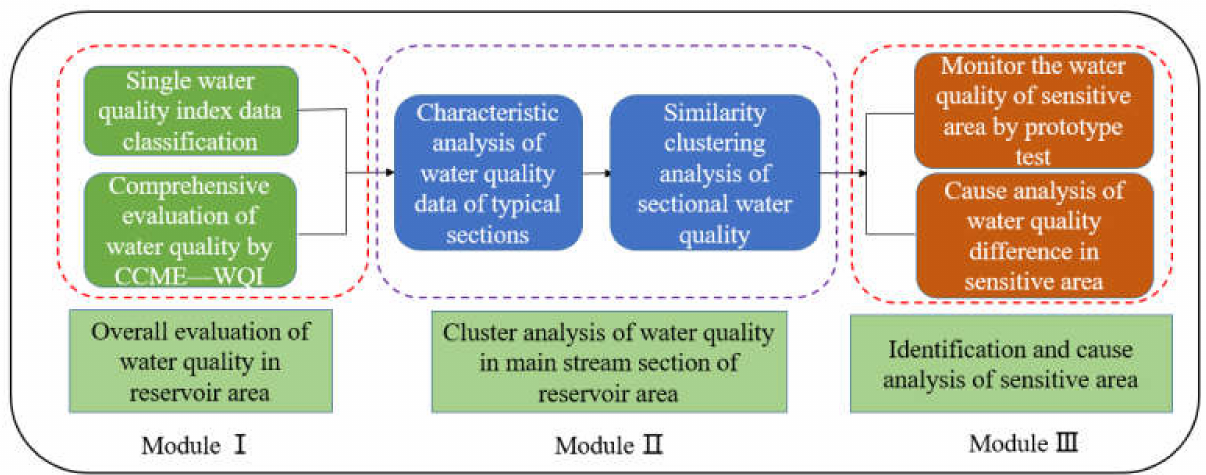
Figure 2. Frame diagram of identification of sensitive areas in relation to water quality concerns. CCME-WQI, Canadian Council of Ministers of the Environment Water Quality